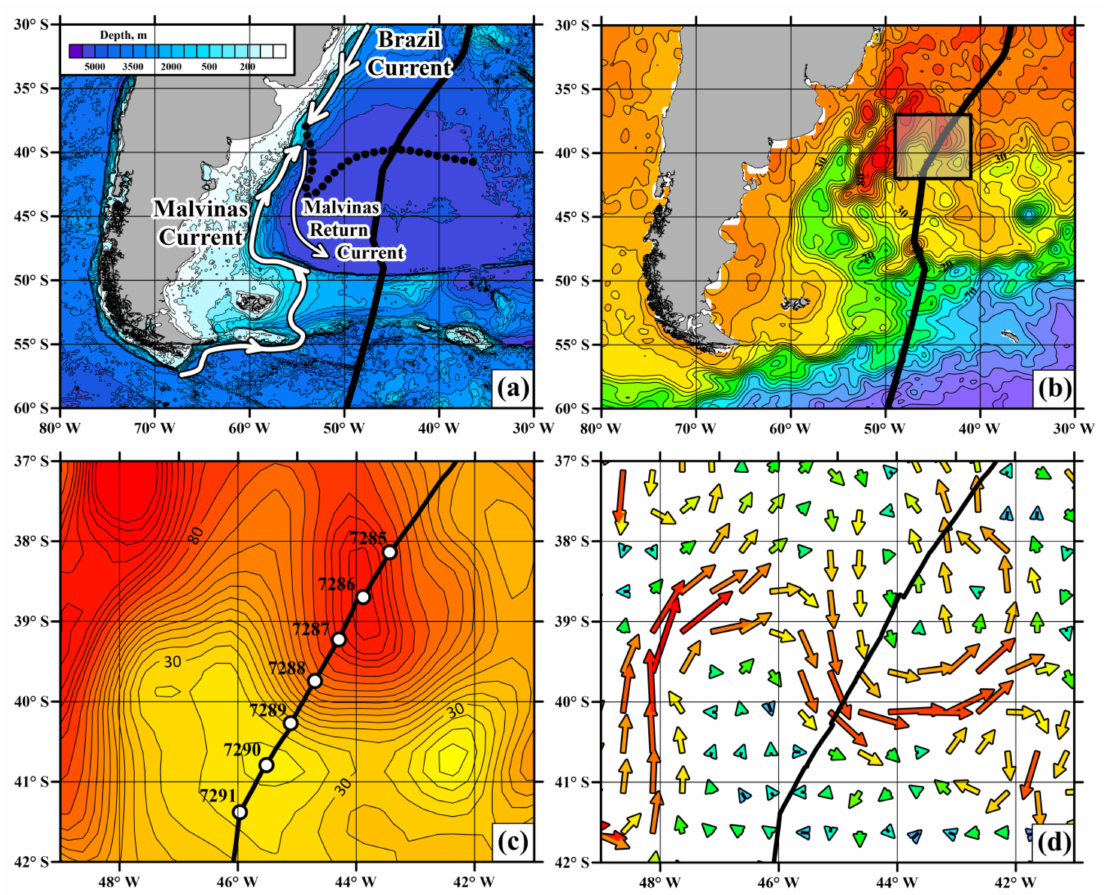
Figure 1. Location of measurements on 11–13 January 2022. Panel ( a ): schematic of the surface circulation in the Southwest Atlantic. The location of the Brazil–Malvinas Confluence zone is